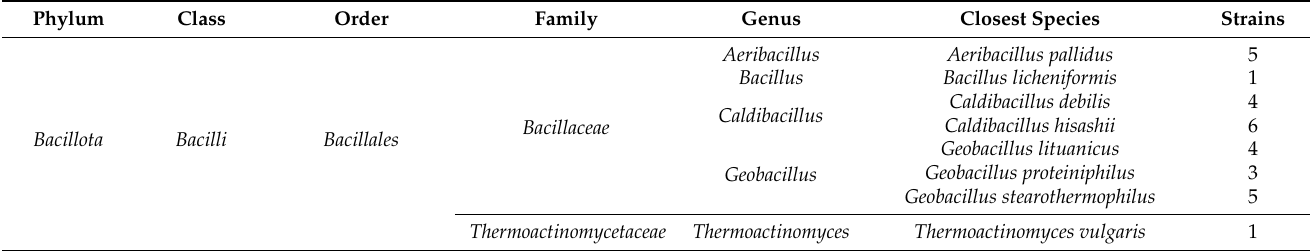
Table 3. Phylum analysis of aerobically cultured thermophilic bacteria isolated from the diverse hot springs in Republic of